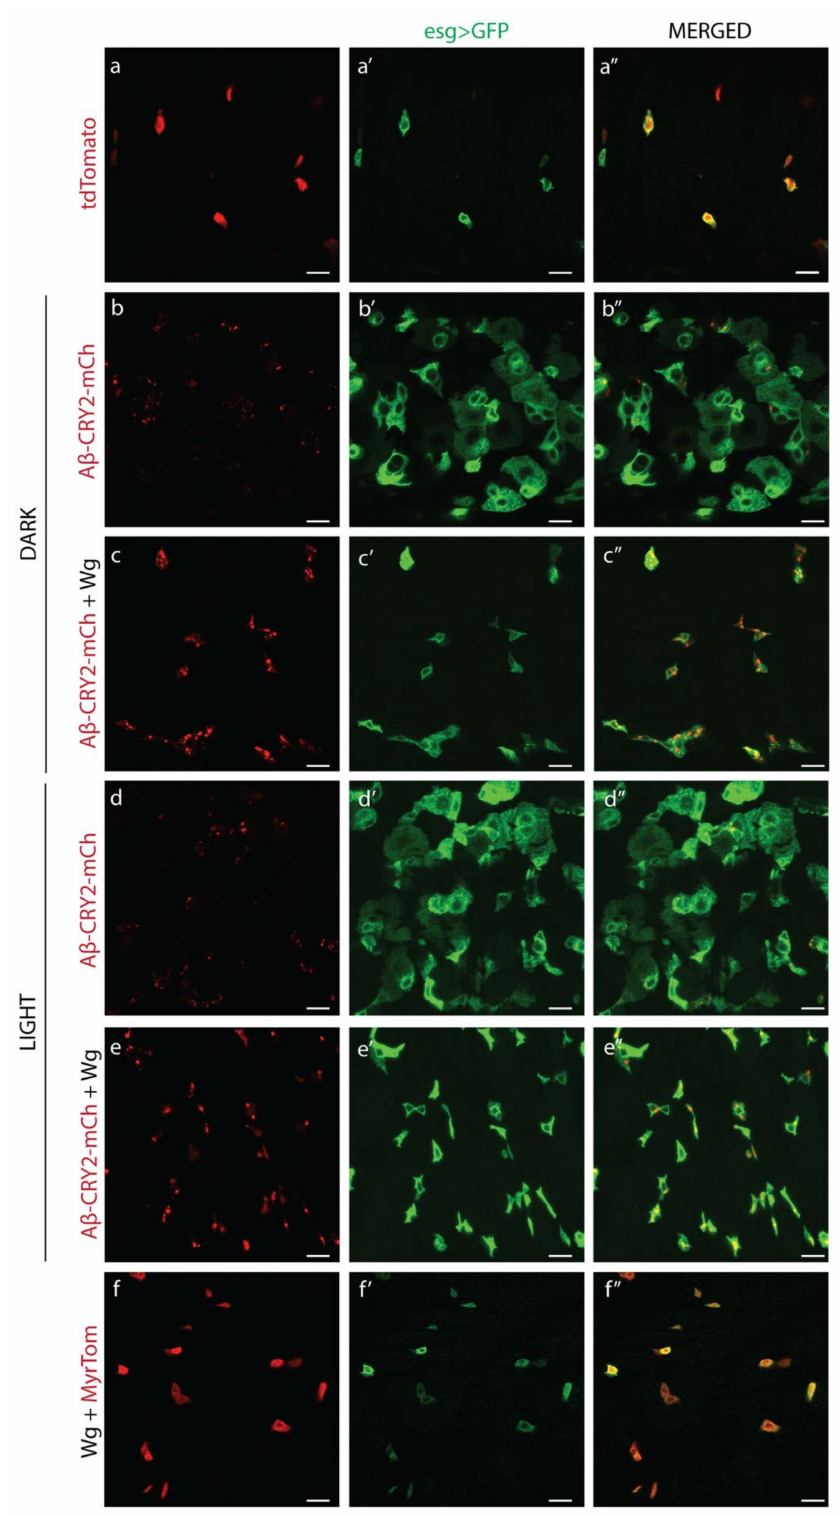
Figure 3. Wnt and amyloid expression in ISCs. Images of midgut sections of ( a – a” ) esg-Gal4 > UAS- GFP, UAS-Td-Tomato flies, ( b – b” ) esg-Gal4 > UAS-GFP, UAS-A β 1 − 42 -CRY2-mCh flies kept in the dark, ( c – c” ) esgGal4 > UAS-GFP, UAS-wg, UAS-A β 1 − 42 -CRY2-mCh flies kept in the dark, ( d – d” ) esg- Gal4 > UAS-GFP, UAS-A β 1 − 42 -CRY2-mCh flies kept in the light, ( e – e” ) esg-Gal4 > UAS-GFP, UAS-wg, UAS-A β 1 − 42 -CRY2-mCh flies kept in the light and ( f – f” ) esg-Gal4 > UAS-GFP, UAS-wg, UAS-myr- Tomato flies. Scale bar represents 10 µ